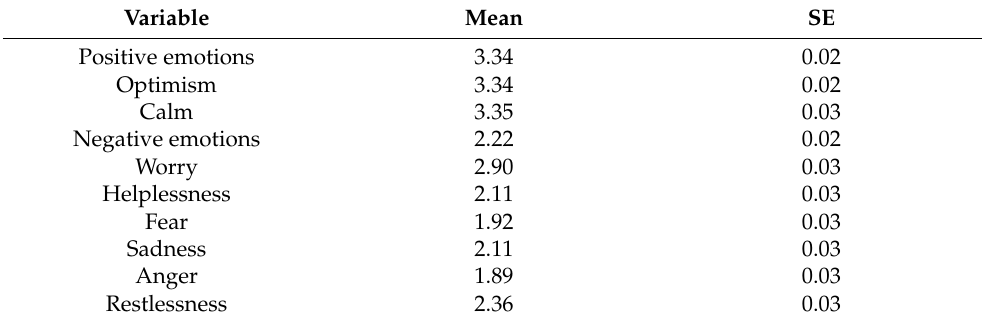
Table 2. Social emotions during the pandemic control. Variable Mean SE Positive emotions 3.34